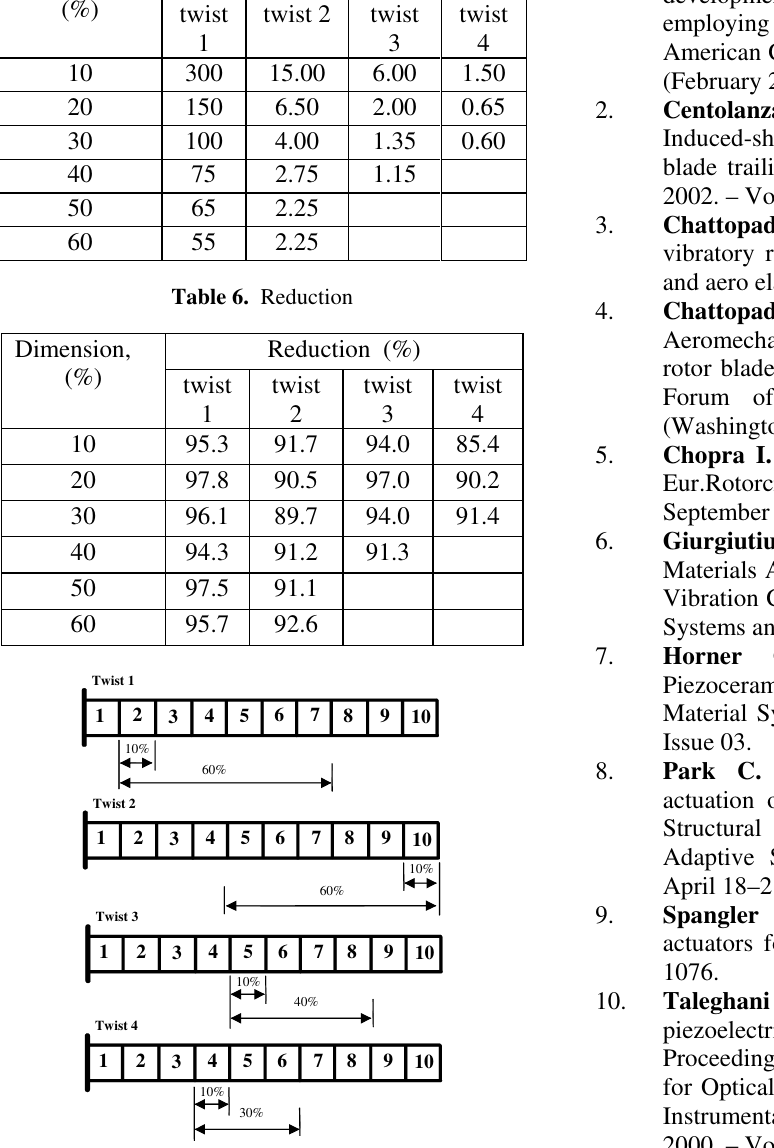
Fig 4. Schematic diagrams of the cases